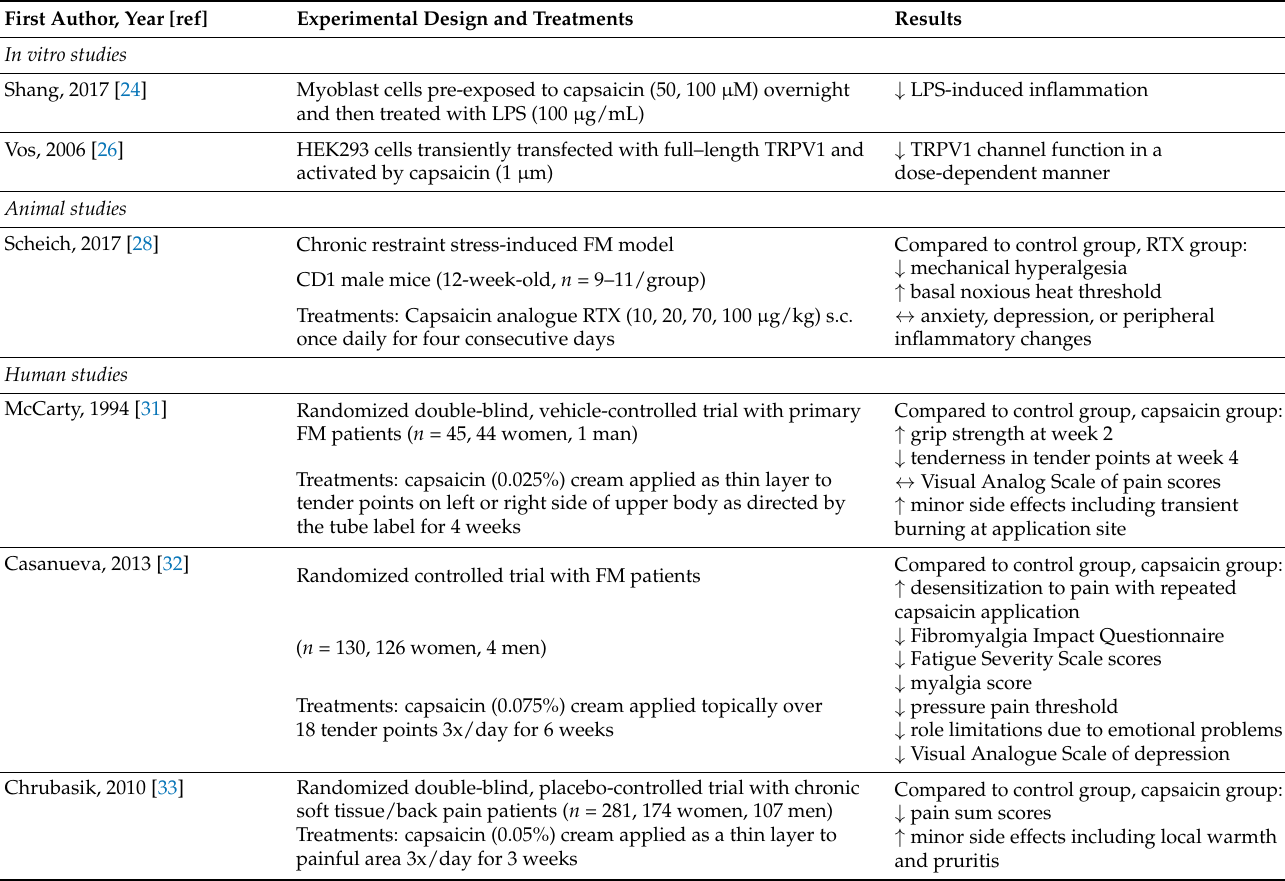
Table 1. Effects of capsaicin on fibromyalgia-like